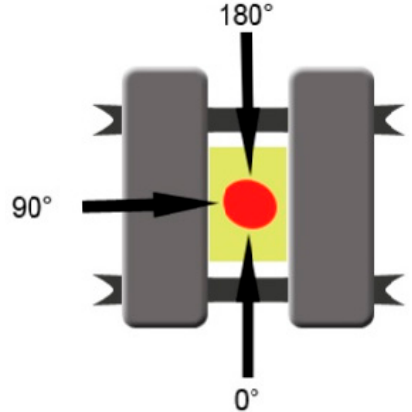
Figure 4. Points indicating the directions of the Periotest used in this study to examine di ff erences in mobility of the implants in various stages of testing. The 270 ◦ angle could not be used for measurements because of the arm of the testing